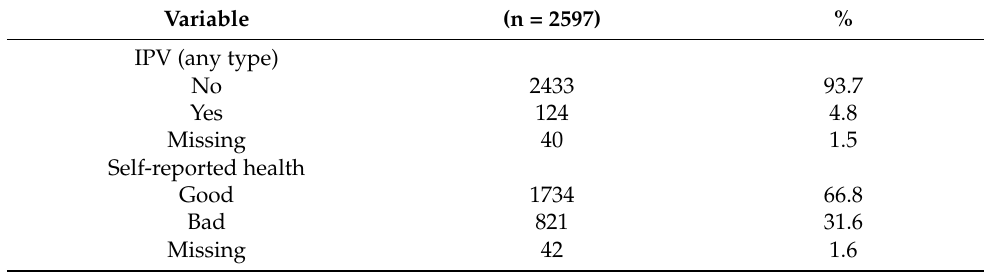
Table 1. Characteristics of the male sample, Gävleborg County Health in Equal Terms Survey 2018.